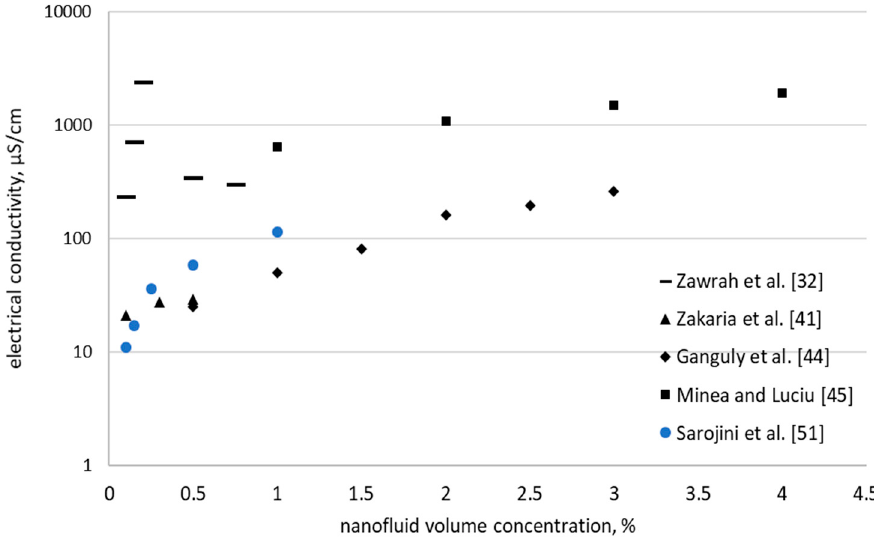
Figure 1. Electrical conductivity of alumina-water nanofluid.